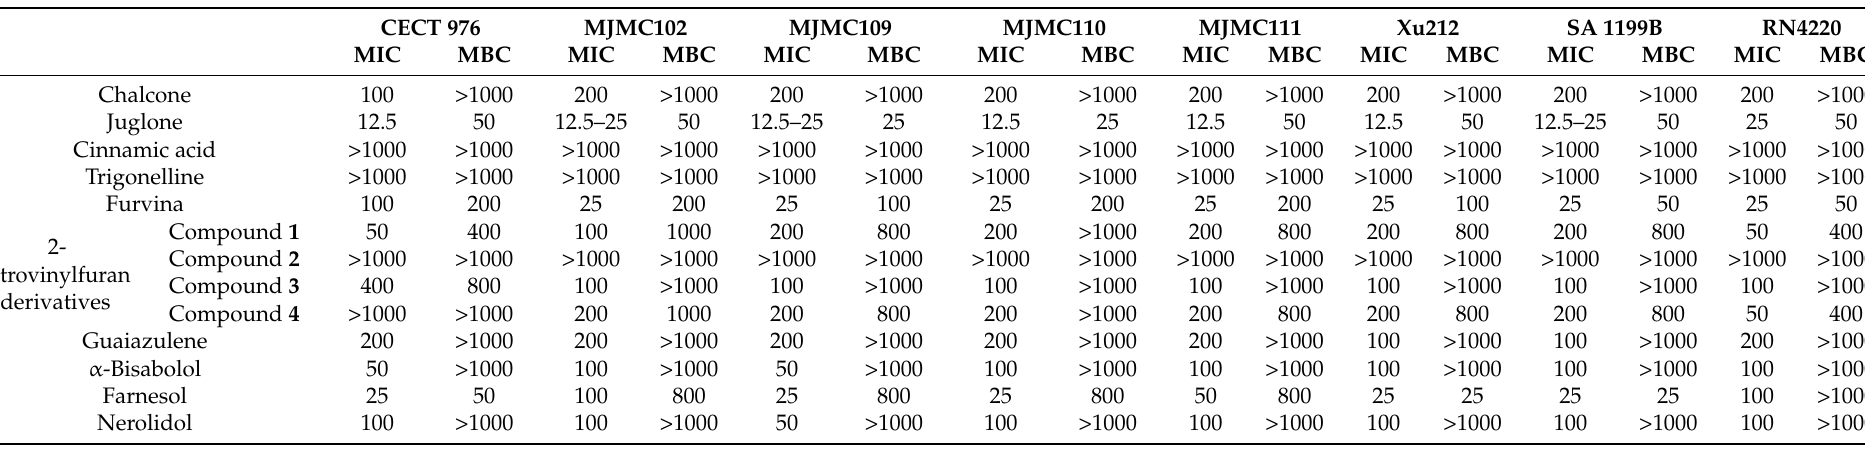
Table 2. MIC and MBC (mg/mL) values of the selected phytochemical-based molecules for S. aureus collection (CECT 976), S. aureus clinical isolates